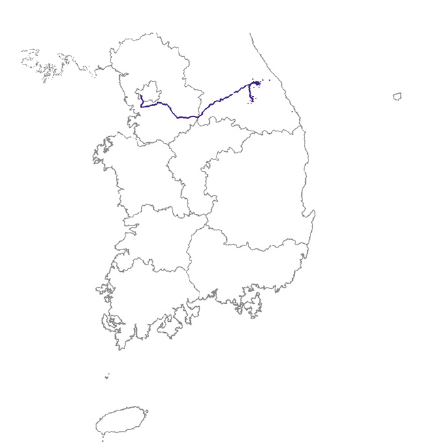
Figure 3: Collection sites of Mini-AWS data.